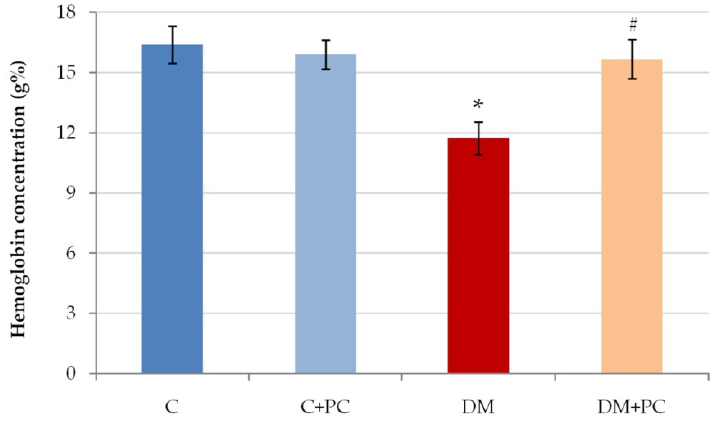
Figure 5. The concentration of hemoglobin in the blood of control rats, rats with experimental diabetes mellitus, with and without PC concentrate. C–normal untreated control animals; C + PC–animals that were per os administrated PC concentrate (daily dose of 45 mg/kg bw of polyphenolic complex for 14 days); DM–rats with experimental diabetes mellitus; DM + PC–animals with experimental diabetes mellitus that were per os administrated PC concentrate (daily dose of 45 mg/kg bw of polyphenolic complex for 14 days). *-significant difference compared to control ( p < 0.05); #-significant difference compared to diabetes mellitus ( p < 0.05).